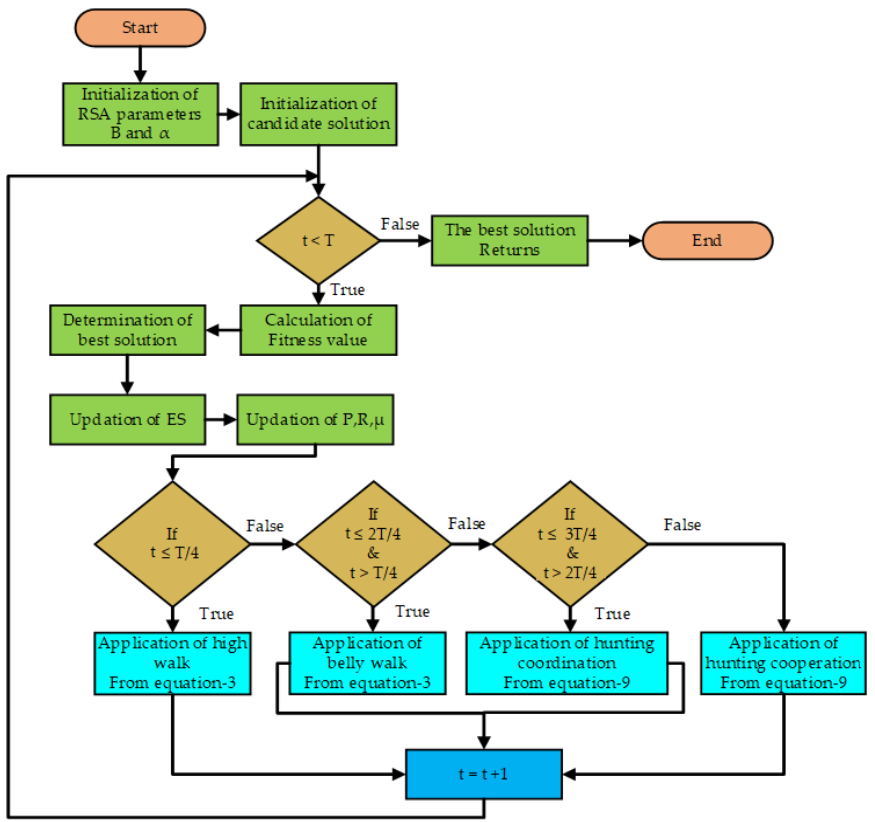
Figure 4. Flowchart of reptile search algorithm (RSA).